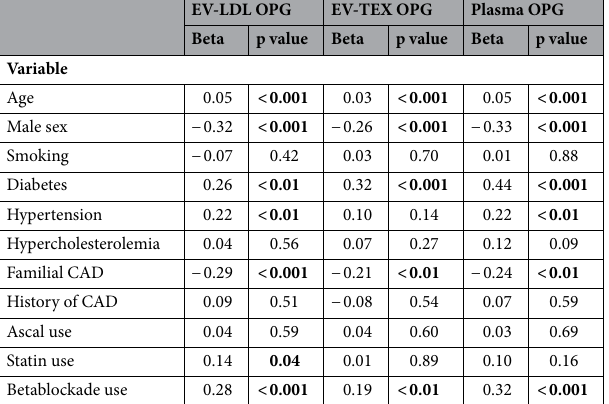
Table 2. Bivariate correlations between OPG levels and cardiovascular risk predictors. All biomarkers were transformed depending on their original distribution and standardized. EV extracellular vesicle, EV-LDL and EV-TEX both different subpopulation of EVs, CAD coronary artery disease. Bold indicates p value <